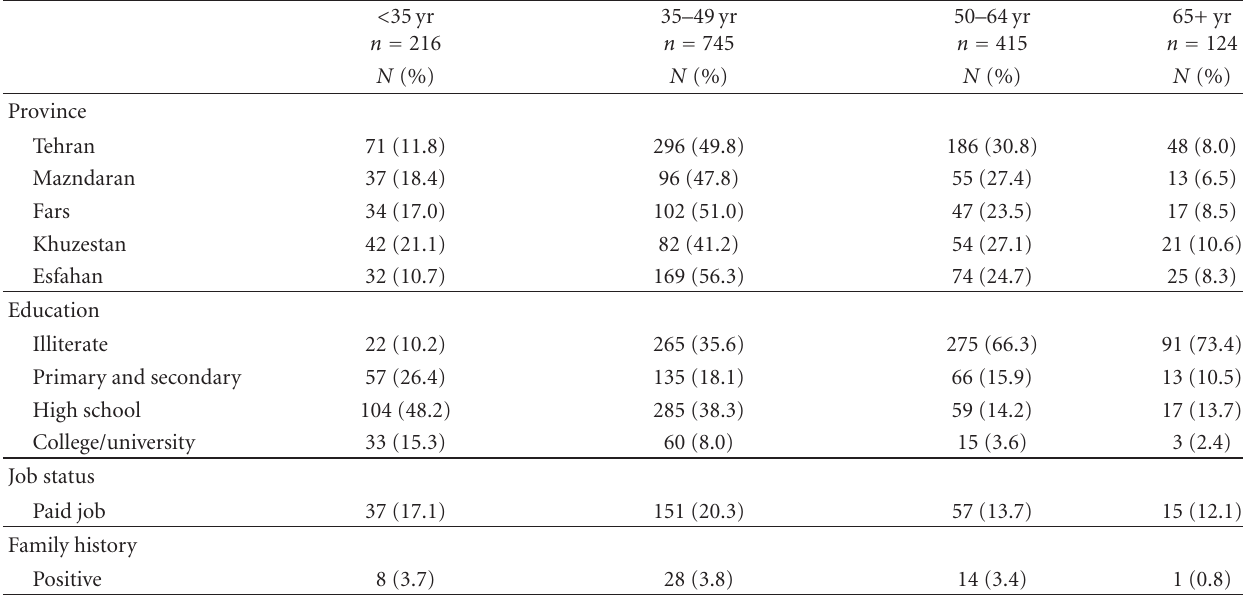
Table 1: Demographic characteristics of 1500 Iranian patients with breast cancer, diagnosed in 1999–2001, by age